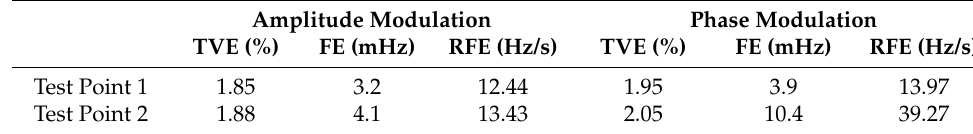
Table 14. Maximum values of TVE, FE and RFE of LPVT.